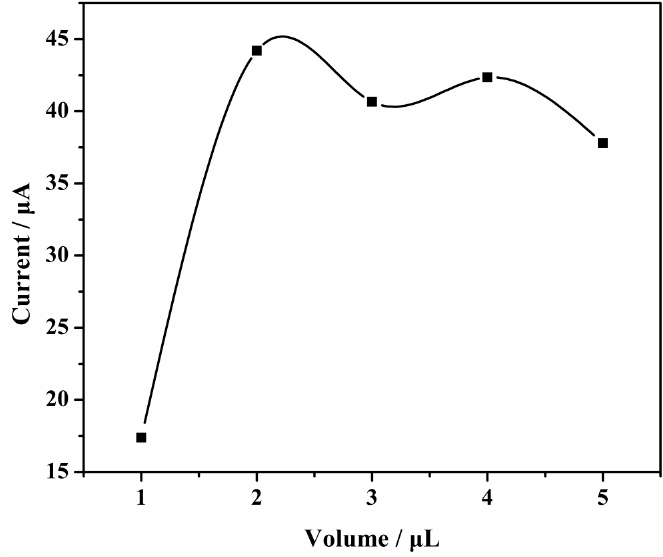
Figure 8. Relationship of the oxidation peak current versus volume of modification.